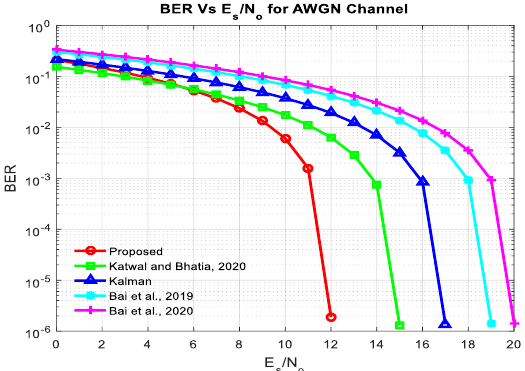
Figure 7. BER vs. E analysis for AWGN channel /N s 0